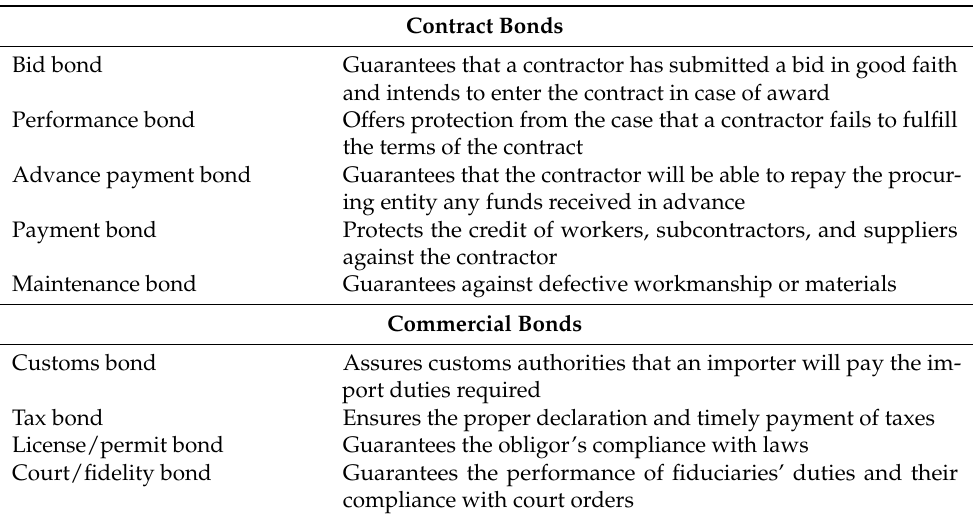
Table 1. A brief description of the main suretyship products.